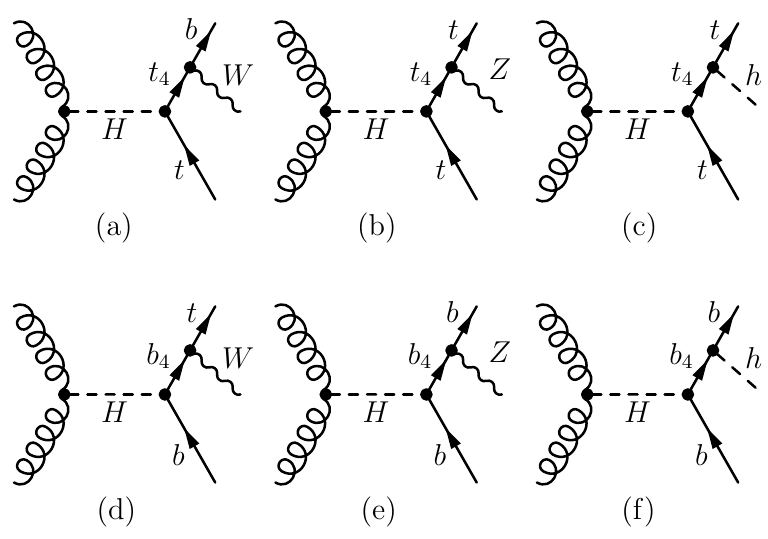
Figure 1 . New decay topologies of a heavy Higgs boson through vectorlike